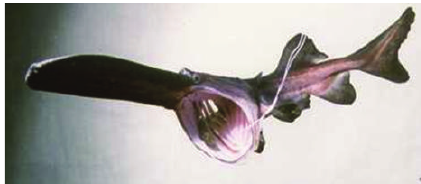
Figure 1: Photograph of a feeding paddlefish. Photograph repro- duced with permission from Pettigrew and Wilkens [1].